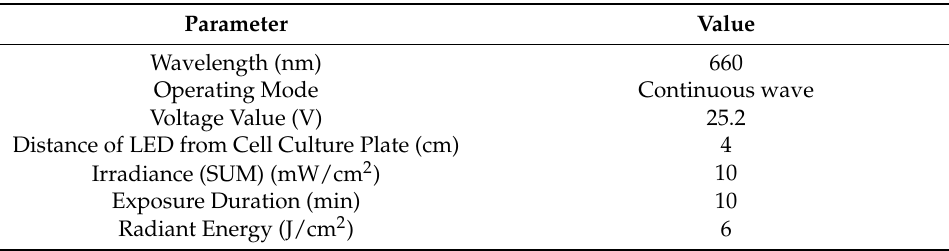
Figure 1. The 660-nanometer LED Irradiation Schedule. ( A ) Representative image of LED irradiation. Graph showing that the LED irradiation was delivered at 660 nm. ( B ) Schema of the astrocyte culturing method and experimental schedule. From DIV0 to DIV6, cells were incubated in DMEM+ (DMEM, FBS, P/S [P = 5000 U/mL, S = 5000 μ g/mL]). On DIV6, cells were subcultured for isolation of astrocytes. Cells were incubated in NB+ medium (Neurobasal, B27, GlutaMAX, P/S (P = 5000 U/mL, S = 5000 μ g/mL)). The LED irradiation protocol was divided into the following two methods: irradiation on DIV7 only, and irradiation on both DIV7 and DIV10. Each colored circle denotes the sampling time for several experiments. The red circle indicates verification for cell differentiation evidence, and the blue and green circles indicate cell proliferation and ROS assay, respectively. Table 1. The parameters of light emitting diodes (LEDs).